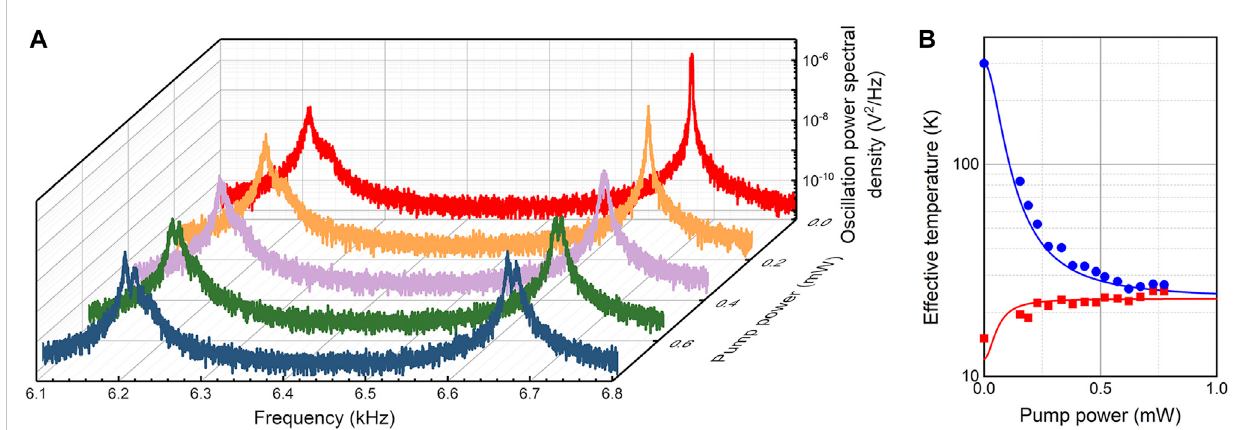
FIGURE 3 (A) Thermal oscillation power spectral density of the modes cooled sympathetically at different pump powers. The spectra for different pump powers are recorded at the feedback gain of g (cid:1) 25. (B) Effective temperature of the two modes cooled sympathetically under different pump powers. Theeffectivetemperaturesofthesymmetricmode(redrectangles)andtheanti-symmetricmode(bluedots)aremeasuredexperimentallybyintegrating thecorrespondingspectrumin (A) arounditsresonant frequency.Also,thetheoreticalresultsforthesymmetricmode(redline)andanti-symmetric mode (blue line) calculated at the same condition of our experiment are plotted for